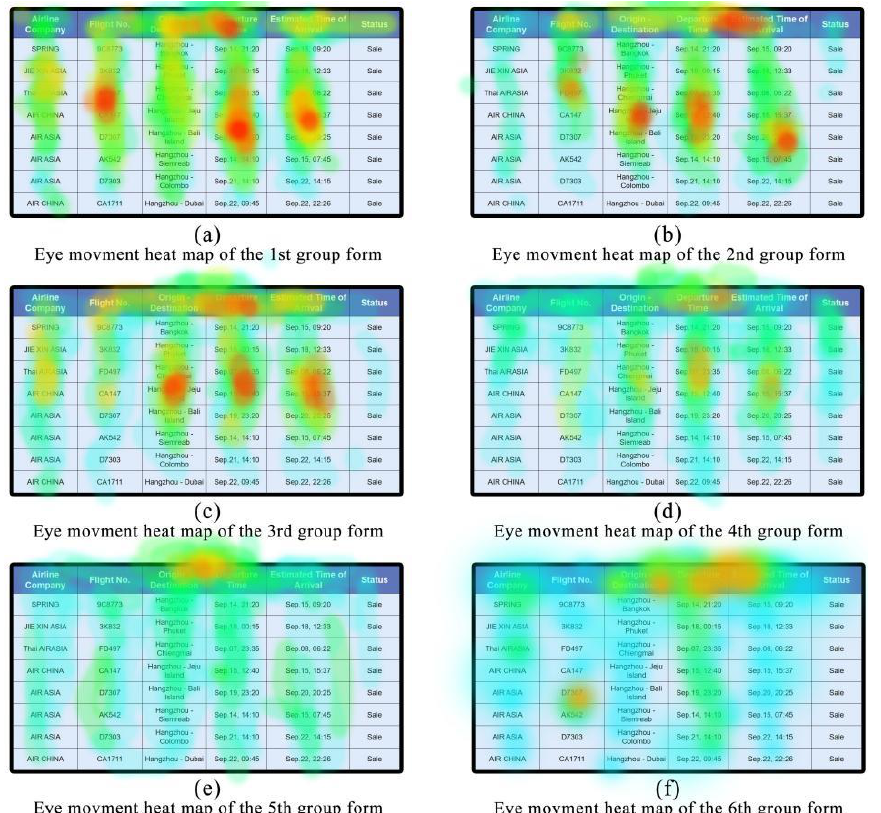
Figure 8. Eye movement heat maps in 6 group forms.